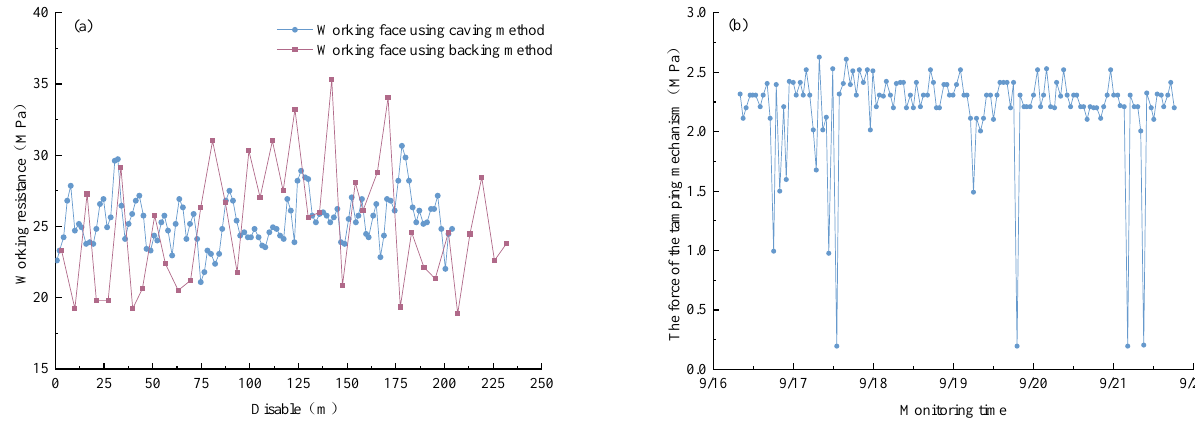
Figure 25. The measured results of backfilling hydraulic support: ( a ) Comparison of the working resistance of hydraulic supports with different mining methods; ( b ) Tamping force of backfilling hydraulic supports.